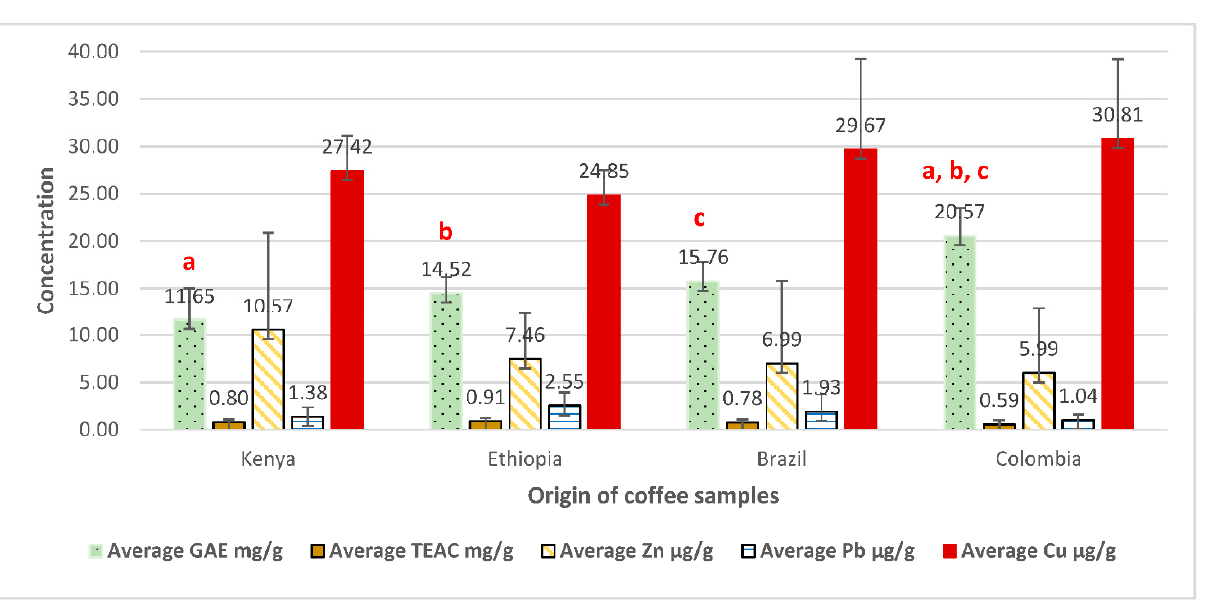
Figure 3. Comparison of coffee samples from different origins (regardless of their roasting degree) in terms of average GAE in mg/g, average TEAC in mg/g, and average Zn, Pb, and Cu contents in µg/g. (Data for heavy metal content taken from Albals et al. [7]). Bars labeled a,b,c are statistically significant with a p -value < 0.05.